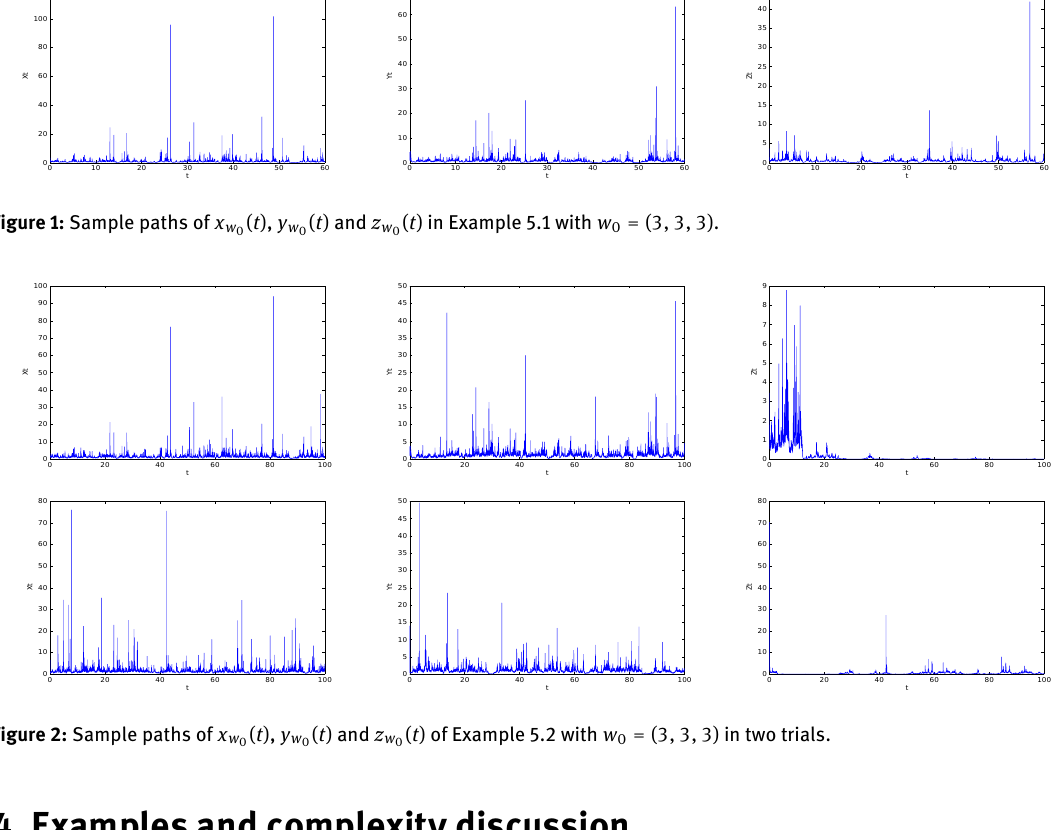
Figure 2: Sample paths of x w